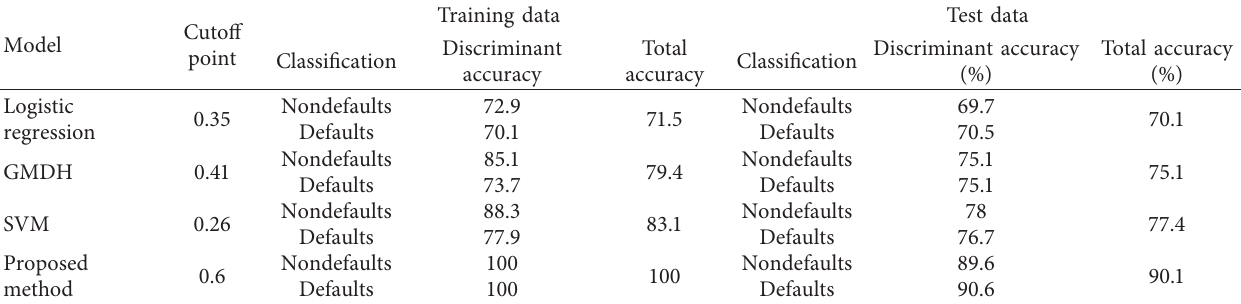
Table 10: Comparison of accuracy rates yielded by different